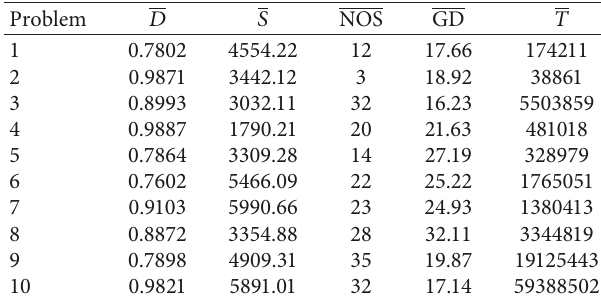
Table 7: Comparative criteria value for